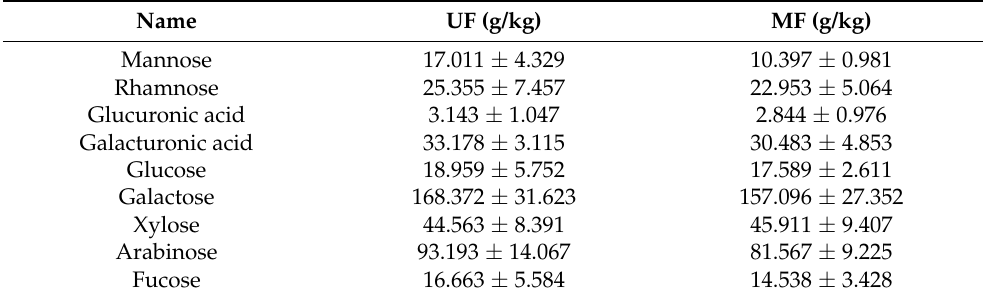
Table 6. Monosaccharide composition of unfermented and mixed fermented soybean